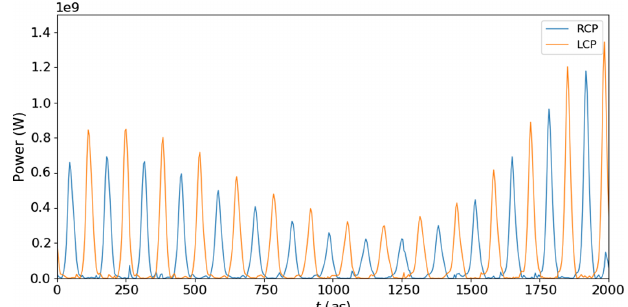
4. Power spectrum for left and right hand polarization vs relative time at the end an afterburner with alternating polarized helical undulator modules.